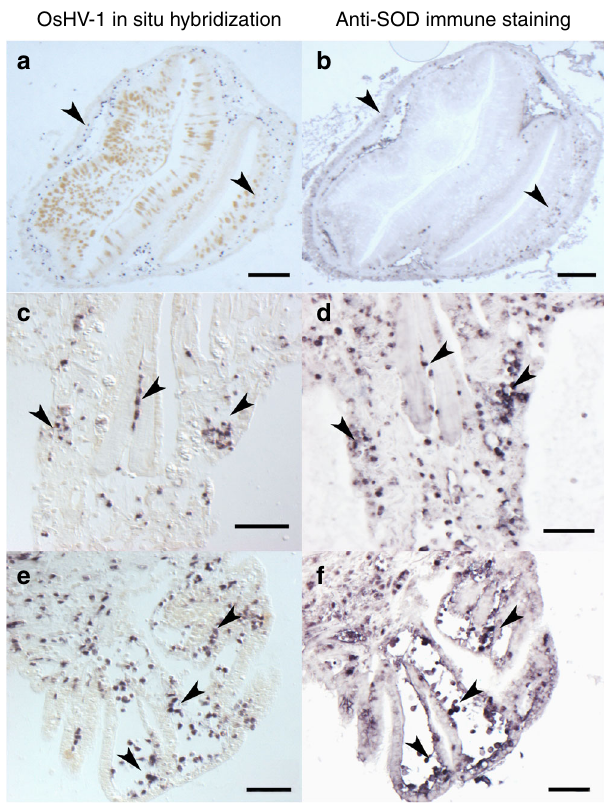
Fig. 7 OsHV-1 invades haemocytes of the susceptible S F11 oysters. OsHV-1 was detected in S F11 by in situ hybridization ( a , c , e ). Paraf fi n wax-